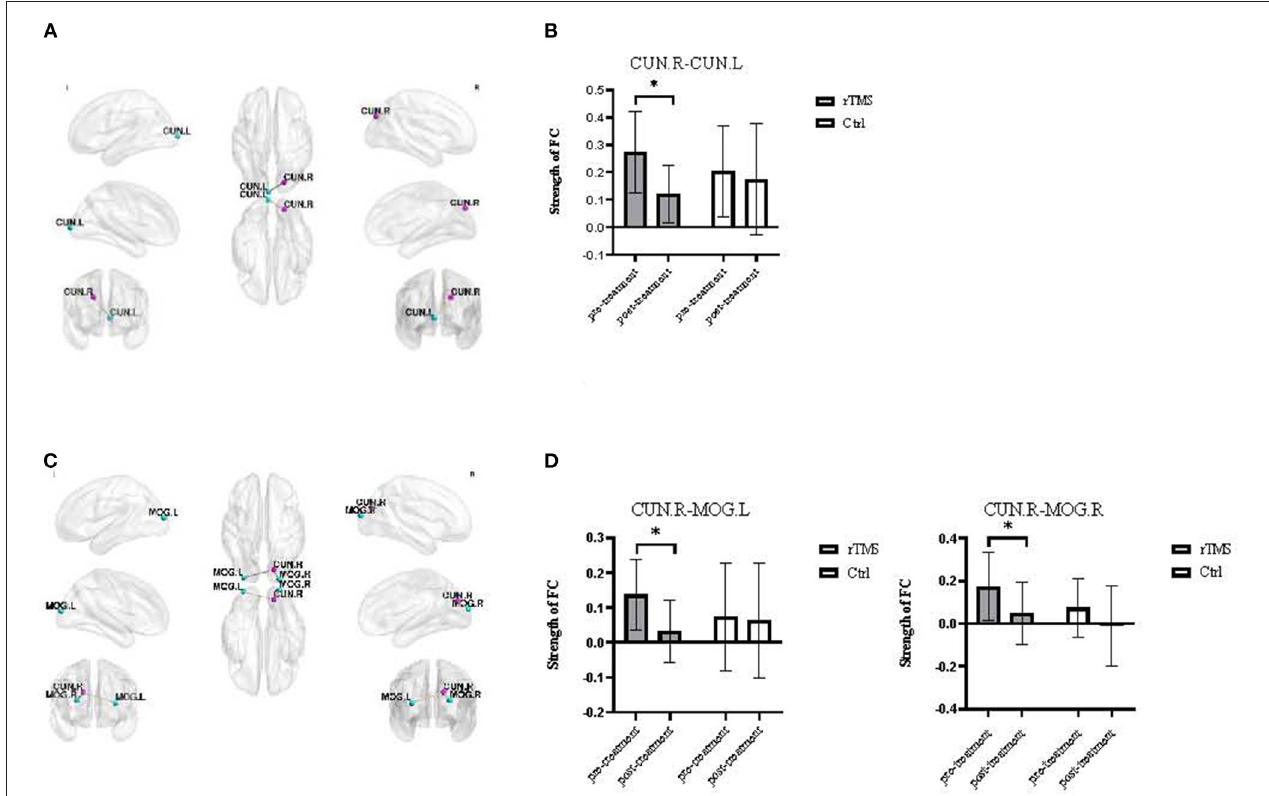
FIGURE 4 | Significantly altered FC after treatment in the rTMS group (voxel p < 0.001, cluster p < 0.05, two-tailed, GRF-corrected). (A) The results of functional connectivity analyses with the seed region located in the CUN.R (18 − 84 33). (B) The panel displays the FC strength values from CUN.R to CUN.L. (C) The results of the functional connectivity analyses with the seed region located in the CUN.R (15 − 81 27). (D) The panel displays the FC strength values from CUN.R to MOG.L and MOG.R. CUN, cuneus; MOG, middle occipital gyrus. * P < 0.05, Post-rTMS compared with pre-rTMS in the same groups.